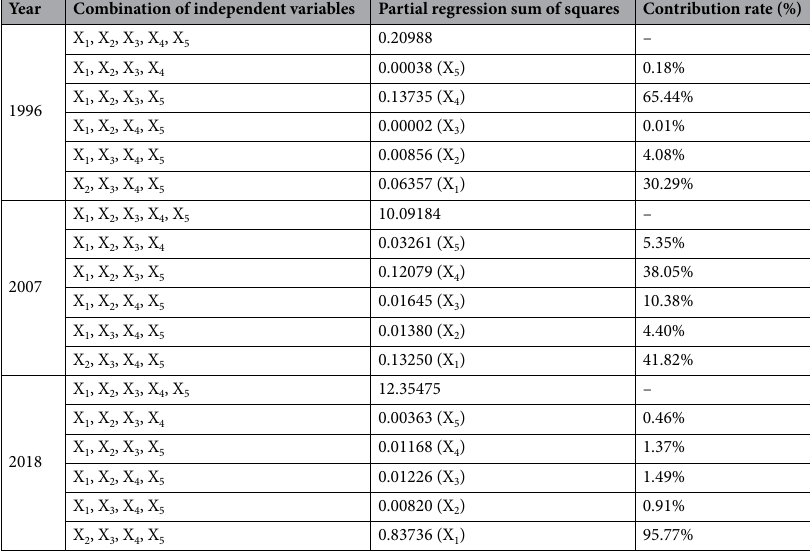
Table 7. Contribution of the landscape pattern index to the ecological vulnerability index. X 1 —NP, X 2 —LPI, X 3 —DIVISION, X 4 —AI, X 5